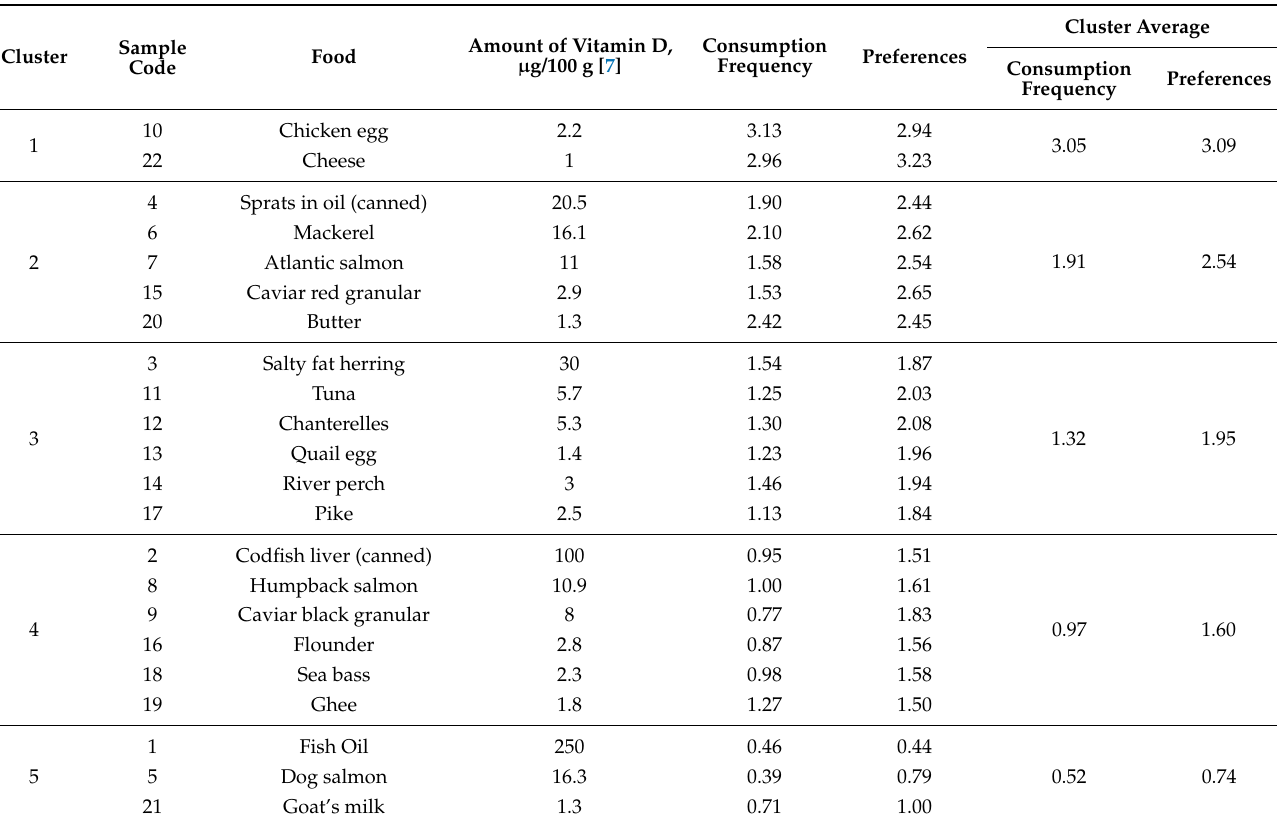
Table 1. Vitamin D-containing foods of